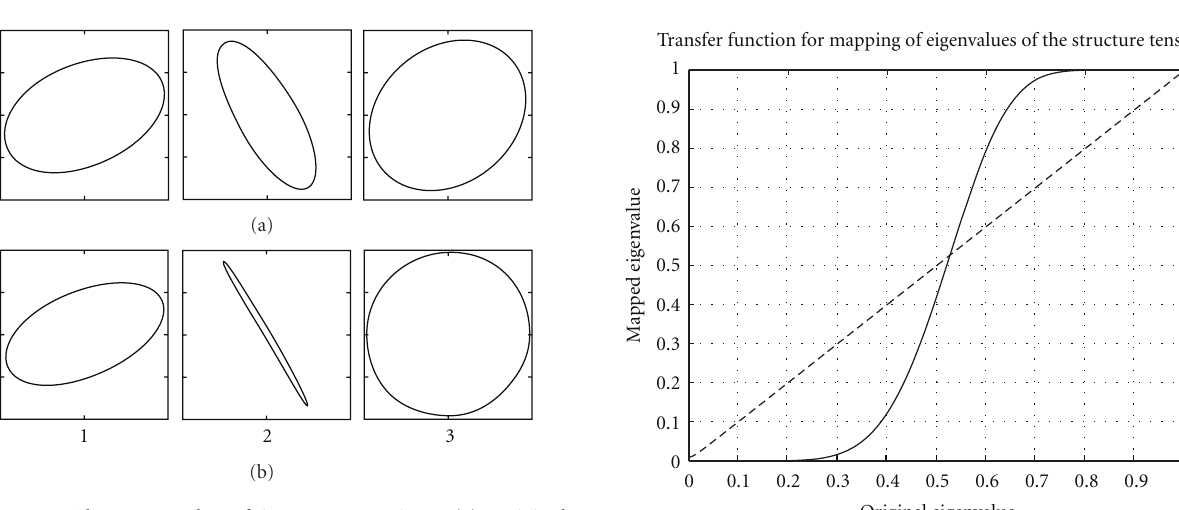
Figure 6: Three examples of isotropy mappings. (a) Original structure tensors. (b) Mapped control tensors. If the structure tensor is anisotropic, the control tensor becomes even more anisotropic (examples 1 and 2). If the structure tensor is almost isotropic, it becomes more isotropic (example 3).